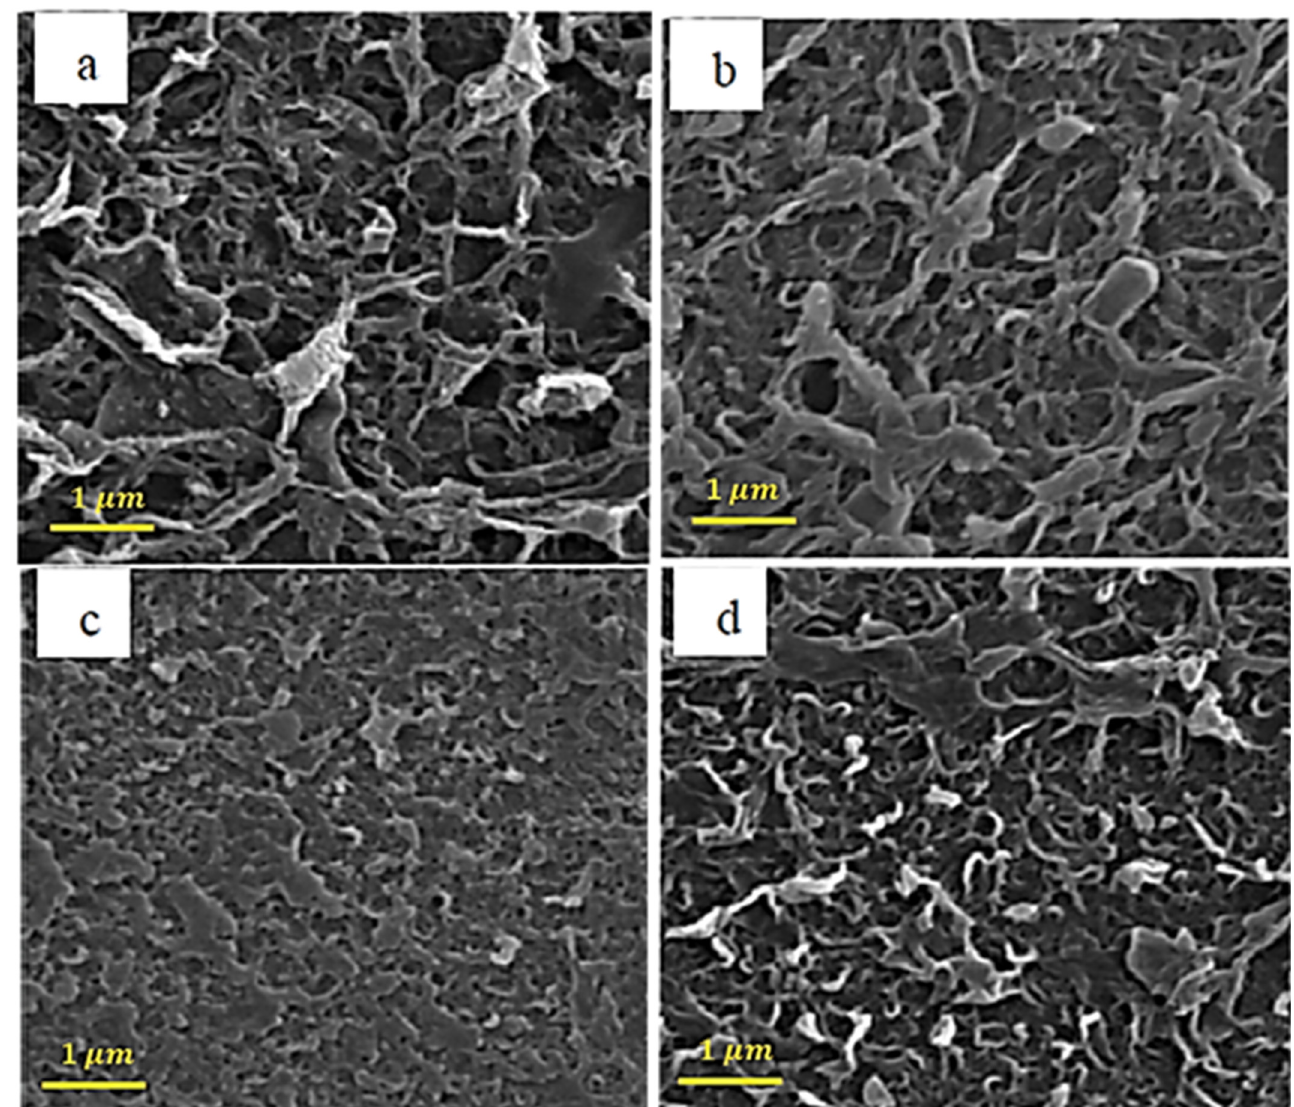
Figure 2. SEM images of the membranes with different loadings of pyrrol ( a ) 0.001 %, ( b ) 0.002%, ( c ) 0.005%, and ( d ) 0.01 %. ( c ) 0.005%, and ( d )